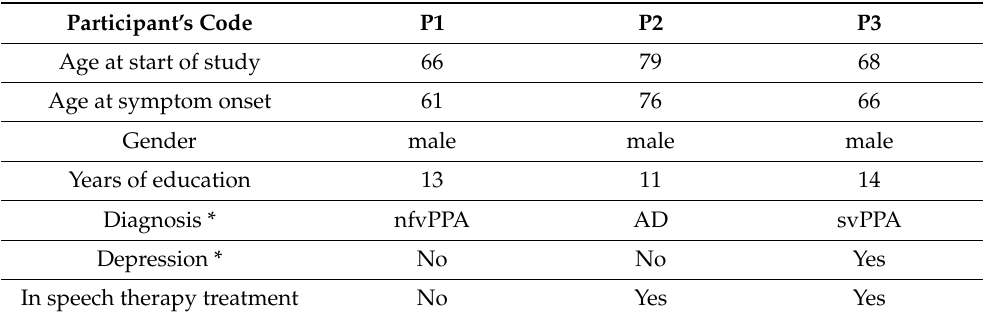
Table 1. Person-related data of selected cases. nfvPPA = non-fluent variant of primary progressive aphasia; AD = Alzheimer’s disease; svPPA = semantic variant of primary progressive aphasia.